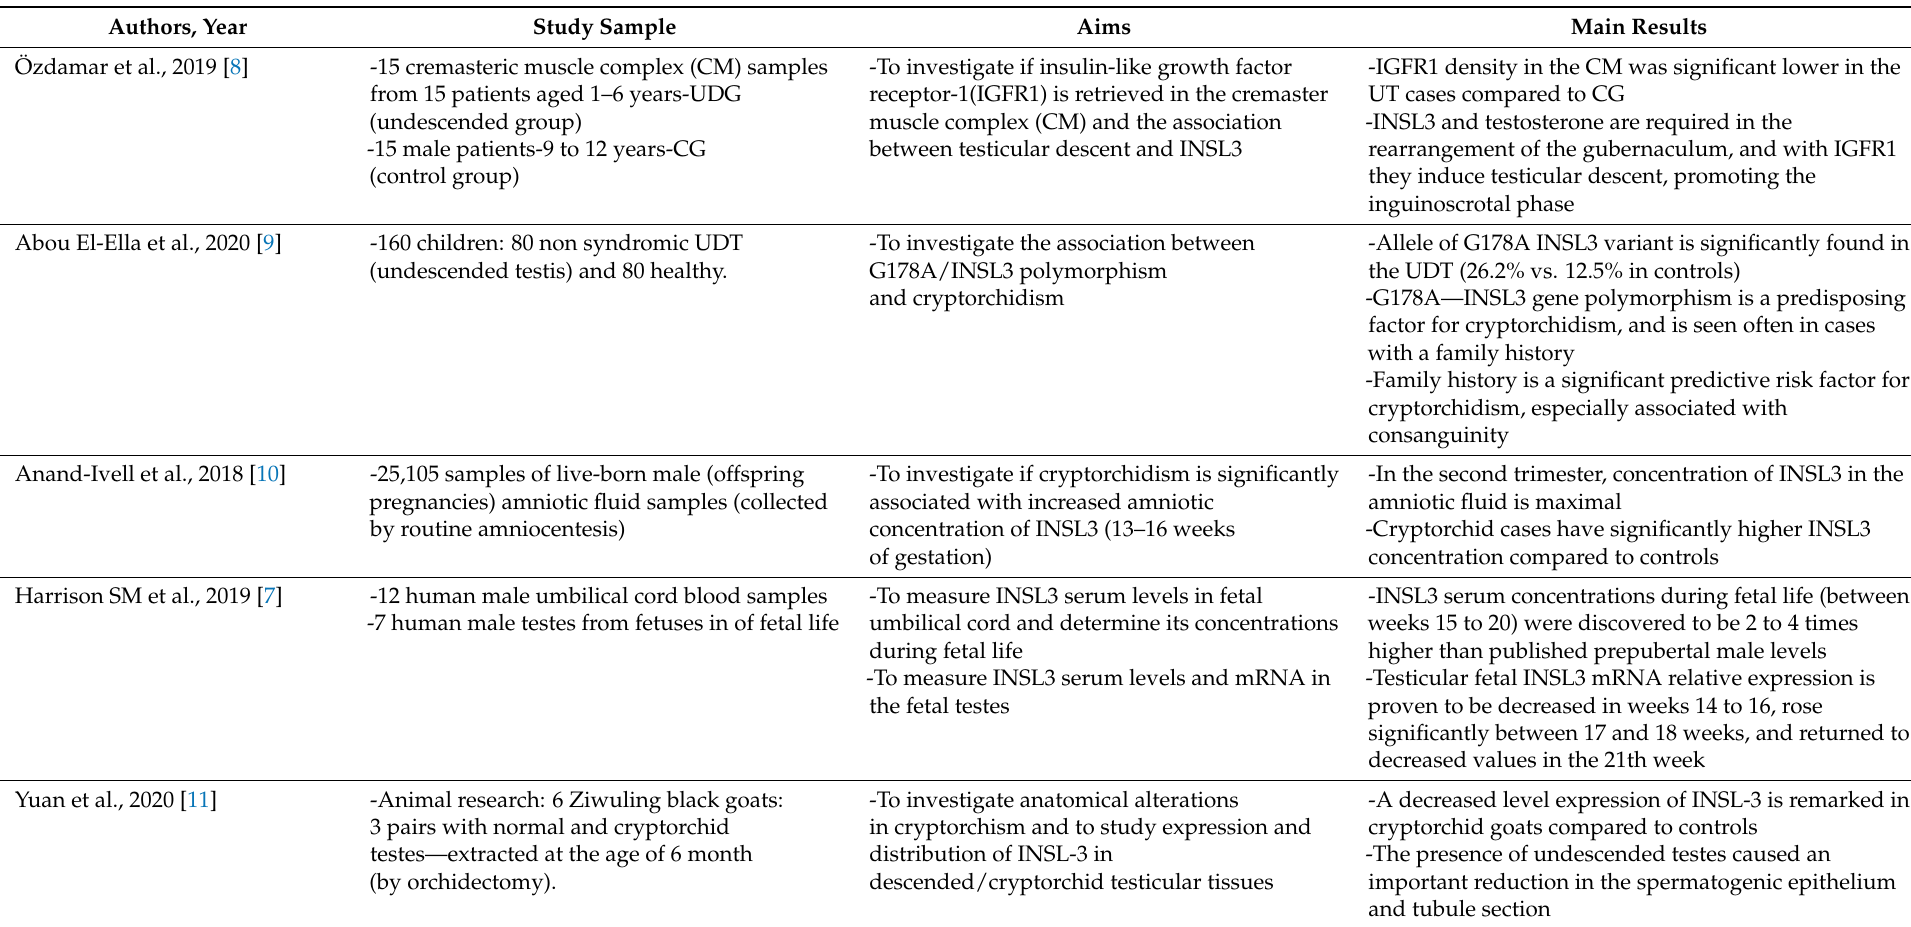
Table 1. Case-control studies depicting the importance of INSL3 and its receptors in testicular descent in both children and